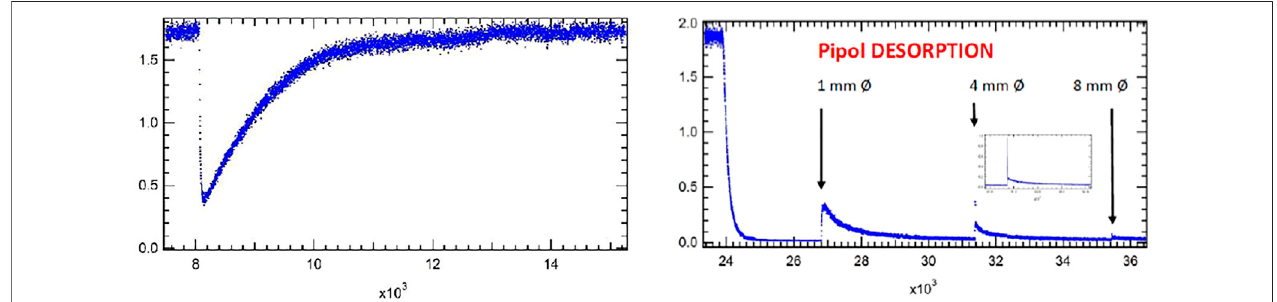
FIGURE 5 | Adsorption and desorption traces for pipol acetate (cis-3-hexene-1-ol acetate) and ATD Coarse (100.4 mg, 10.8 m 2 /g) (FS90/91). Uptake phase: F i = 3.0 × 10 15 molecule s − 1 , 1 mm Ø exit ori fi ce, MS detection at e/m = 67 amu, integral of the blue MS trace corresponds to 100% of a monolayer or 2.9 × 10 14 molecules cm − 2 . SC closed at 16 ′ 300 pts. Computer fi t for desorption phase at 1 mm Ø resulted in k d = 7.0 × 10 − 4 s − 1 with k a = 1.2 s − 1 and k e = 0.0988 s − 1 with a recovery of 13.4% representing 3.8 × 10 13 molecules cm − 2